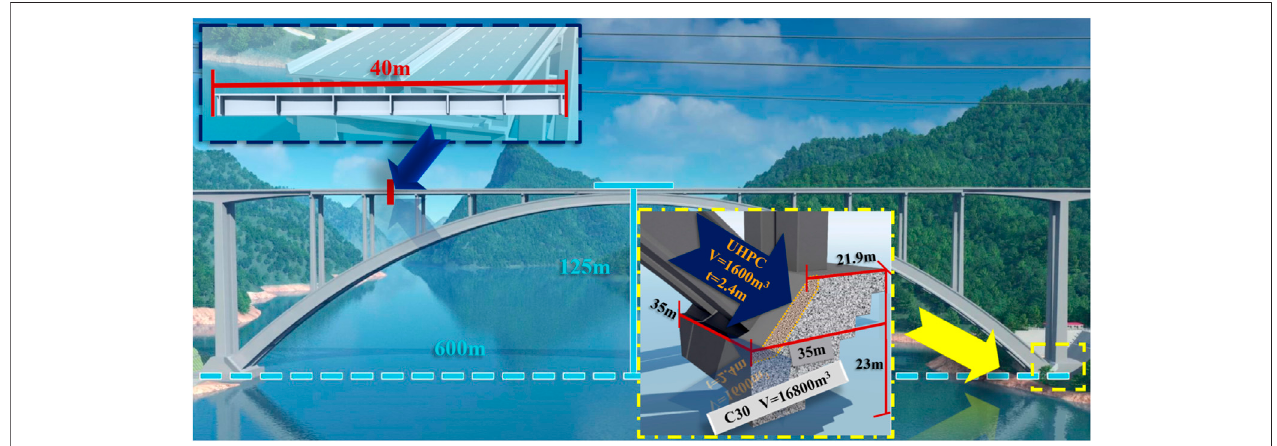
FIGURE 1 | General arrangement of a bridge (unit: